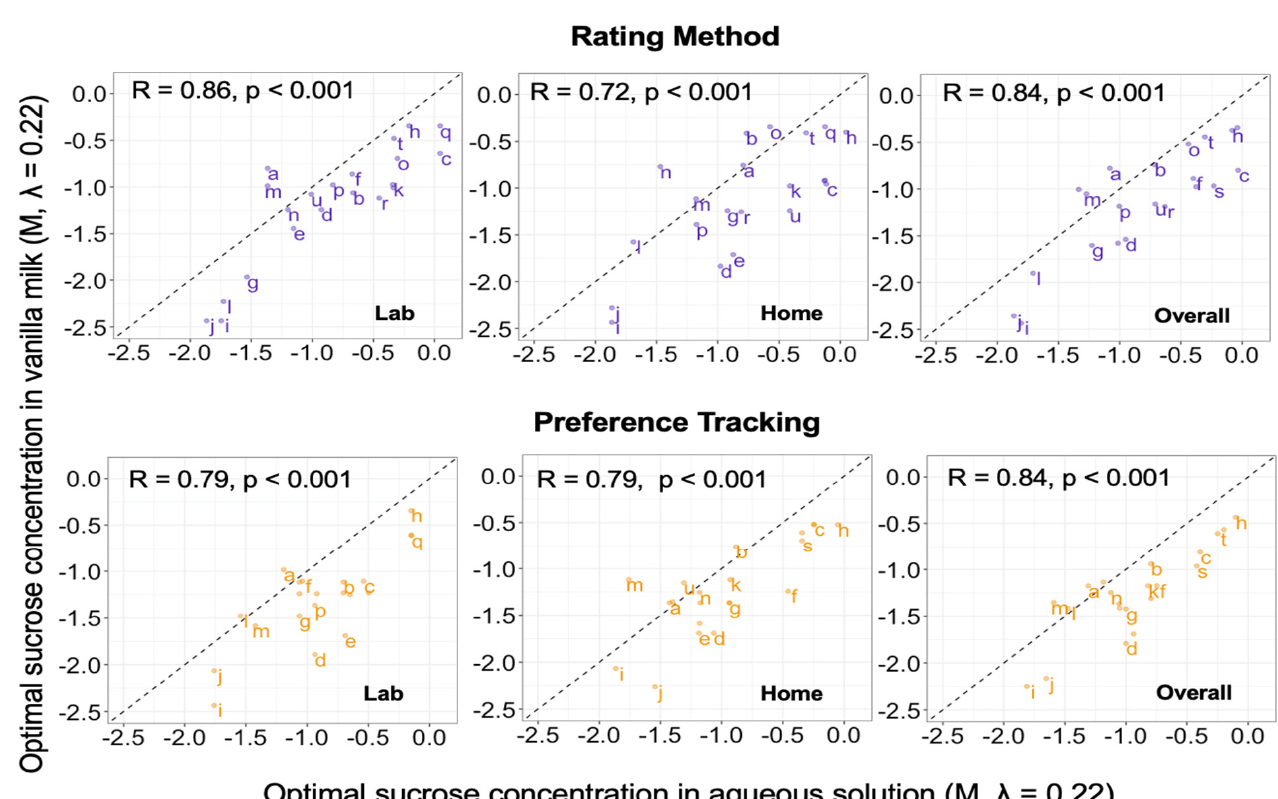
centrations (M). The letters on the plot represent participant ID. Top (blue points): data for aque- ous solutions. Bottom (pink points): vanilla milk. Left to right: measured in the laboratory, meas- ured at home, and averaged across the two test locations (overall). Dotted line: line of equality (y = x line).